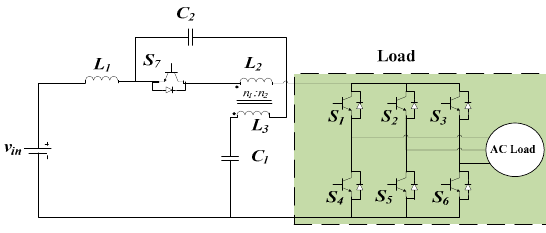
Figure 8. Bidirectional LCCT-Z-source inverter topology.